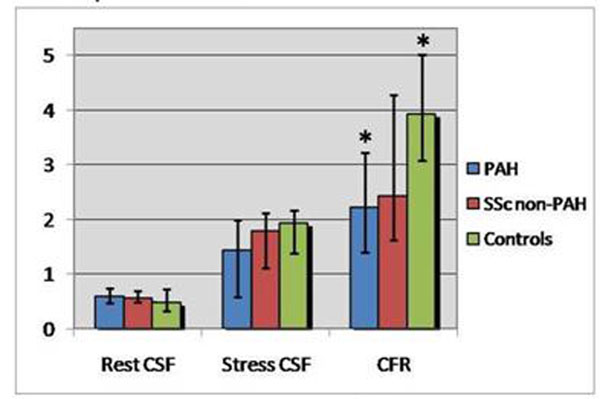
Resting and Stress Coronary Sinus Flow and Coronary Flow Reserve. Bar graphs demonstrate median values and 25th-75th percentiles (error bars) for resting CSF (left), stress CSF (middle) and CFR (right) for each group. Values for PAH patients are shown in blue, those for SSc non-PAH patients in red and those for the control group in green. PAH patients demonstrated a trend toward higher resting and lower stress CSF as well as a significantly lower CFR (*p=0.008) compared to healthy controls. The Non-PAH group demonstrated values in-between those for PAH patients and controls.